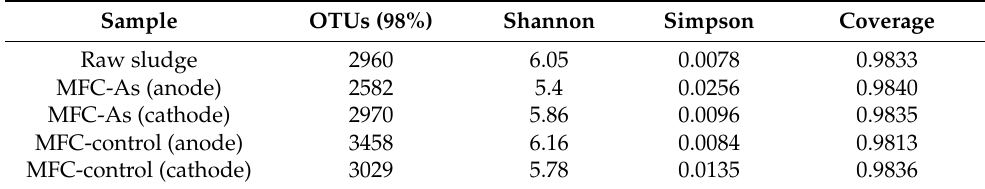
Table 1. Comparison of microbial diversity of each